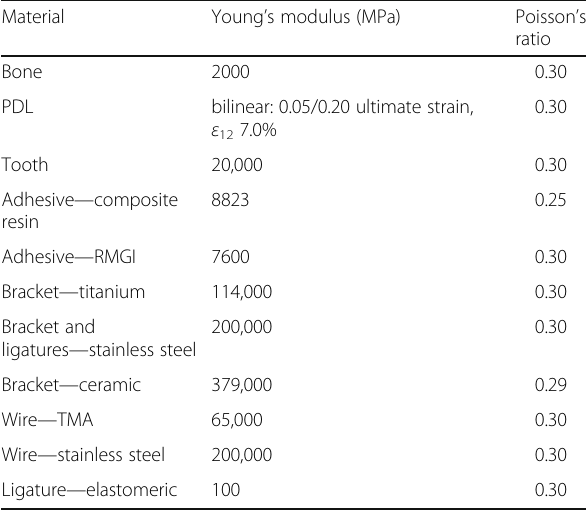
Table 1 Material properties used in this